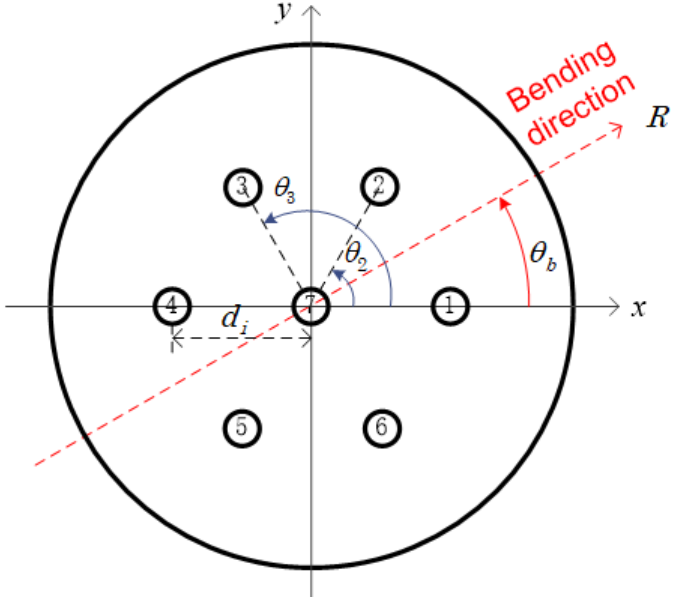
Figure 4. The transversal spatial distribution of cores of a seven-core fiber, showing the definitions of some important geometrical parameters. Reprinted with permission from Ref. [36] © 2016 Optica Publishing Group.